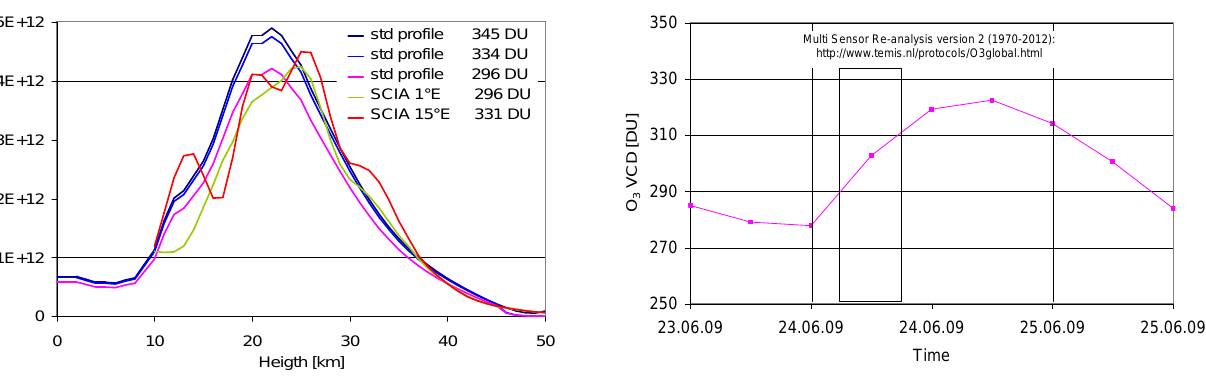
Figure 3. Comparison of different ozone profiles for the day of our measurements. The standard profile used in our simula- tions (345DU) is shown together with two measured profiles from SCIAMACHY (55.62 ◦ N, 1.00 ◦ E: 296DU; 53.89 ◦ N, 15.26 ◦ E: 331DU). In addition, two scaled standard profiles matching the same O 3 VCD as the SCIAMACHY profiles are shown.